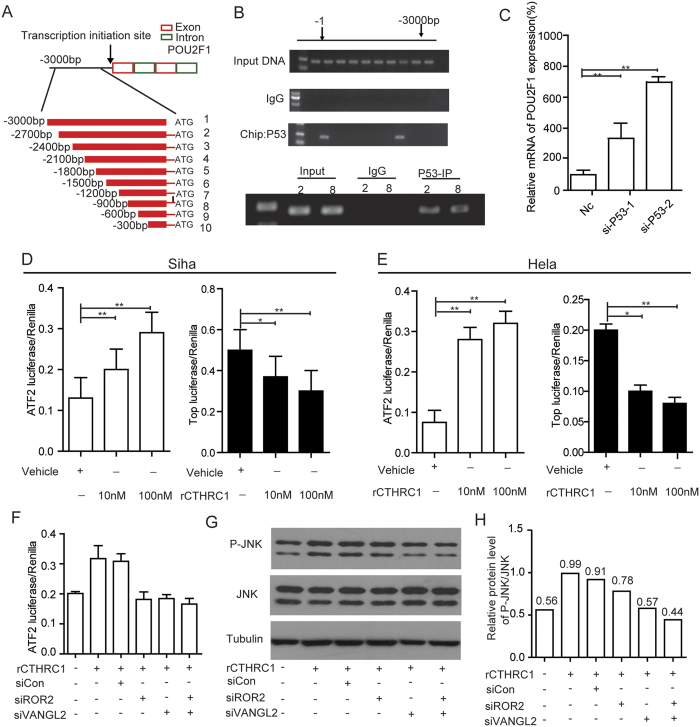
CTHRC1 activates Wnt/PCP signaling pathway.(A) Schematic structure of POU2F1 promoter. The red and green rectangles indicate exon and intron of POU2F1 respectively. The zone between black lines represent the primers used in ChIP analysis. (B) A ChIP assay was performed using chromatin from Caski cells. (C) Silencing of P53 in Caski decreased POU2F1 expression, detected by RT-PCR and normalized with 18S expression. (D and E) Dual-luciferase reporter assay showed that rCthrc1 protein inhibited Wnt/β-catenin signaling and noncanonical Wnt/PCP was activated in Siha and Hela cells by rCTHRC1 protein in a dose-dependent manner. (F) Dual-luciferase reporter assay showed the promotive effect of rCTHRC1 protein on Wnt/PCP signaling was almost blocked after sliencing of ROR2, VANGL2 or ROR2 + VANGL2, respectively. (G) Western blot analysis of phosphorylation level of JNK after rCTHRC1 (100 nM) treatment in Hela cells. Treatment of HeLa cells with rCTHRC1 could promote the phosphorylation of JNK, while sliencing of ROR2, VANGL2 or ROR2 + VANGL2, respectively, almost fully reversed this phenomenon. (H) Quantitative analysis of grey value for phospho-JNK/total JNK ratio using ImageJ software.